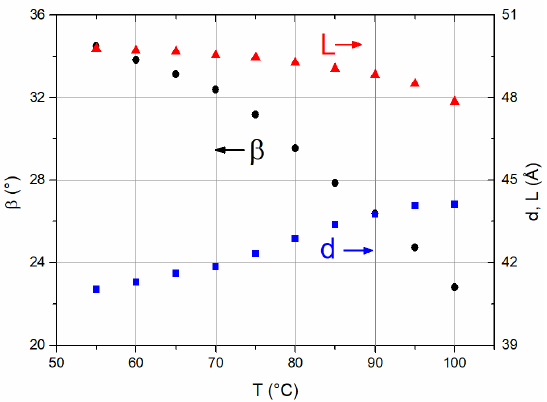
Figure 10. Molecular tilt angle β (black circles), layer spacing d (blue squares) and molecular length L (red triangles) as a function of the temperature T . Data obtained from the analysis of the SA diffraction patterns as described in the text.